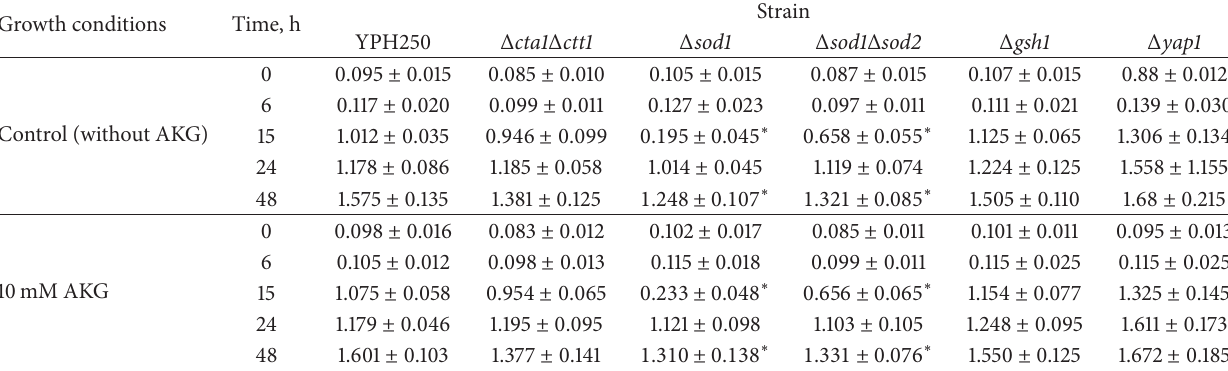
Table 1: Growth of different S. cerevisiae strains measured by absorbance at 620 nm (OD 620 ) at certain time periods. Growth conditions